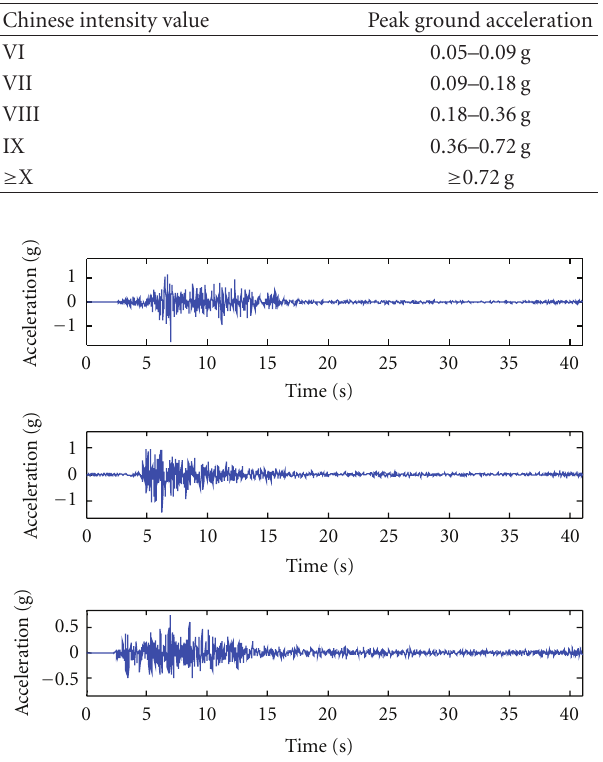
Figure 7: Acceleration time histories at Tianshui (B1) from scenario B.